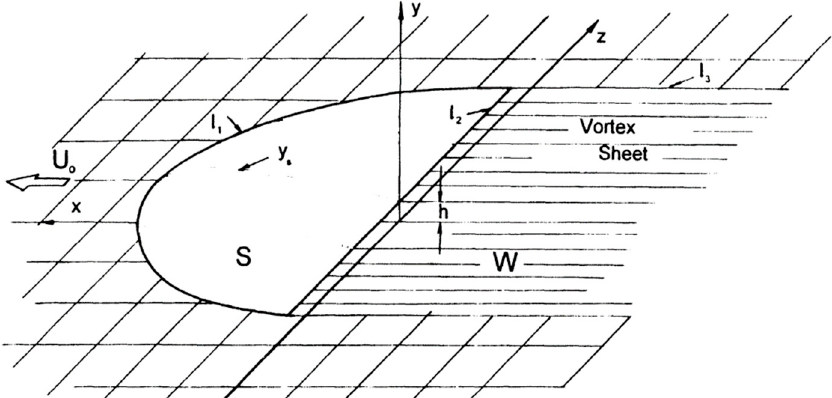
Figure 1. A lifting surface oscillating in close proximity to the ground, S , W are areas of the wing and wake.